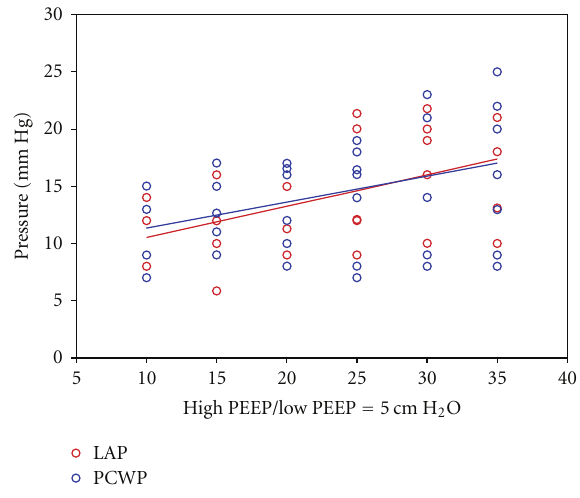
Figure 1: Illustration of variability in LAP and PCWP as high PEEP is increases with constant low PEEP of 5cm H 2